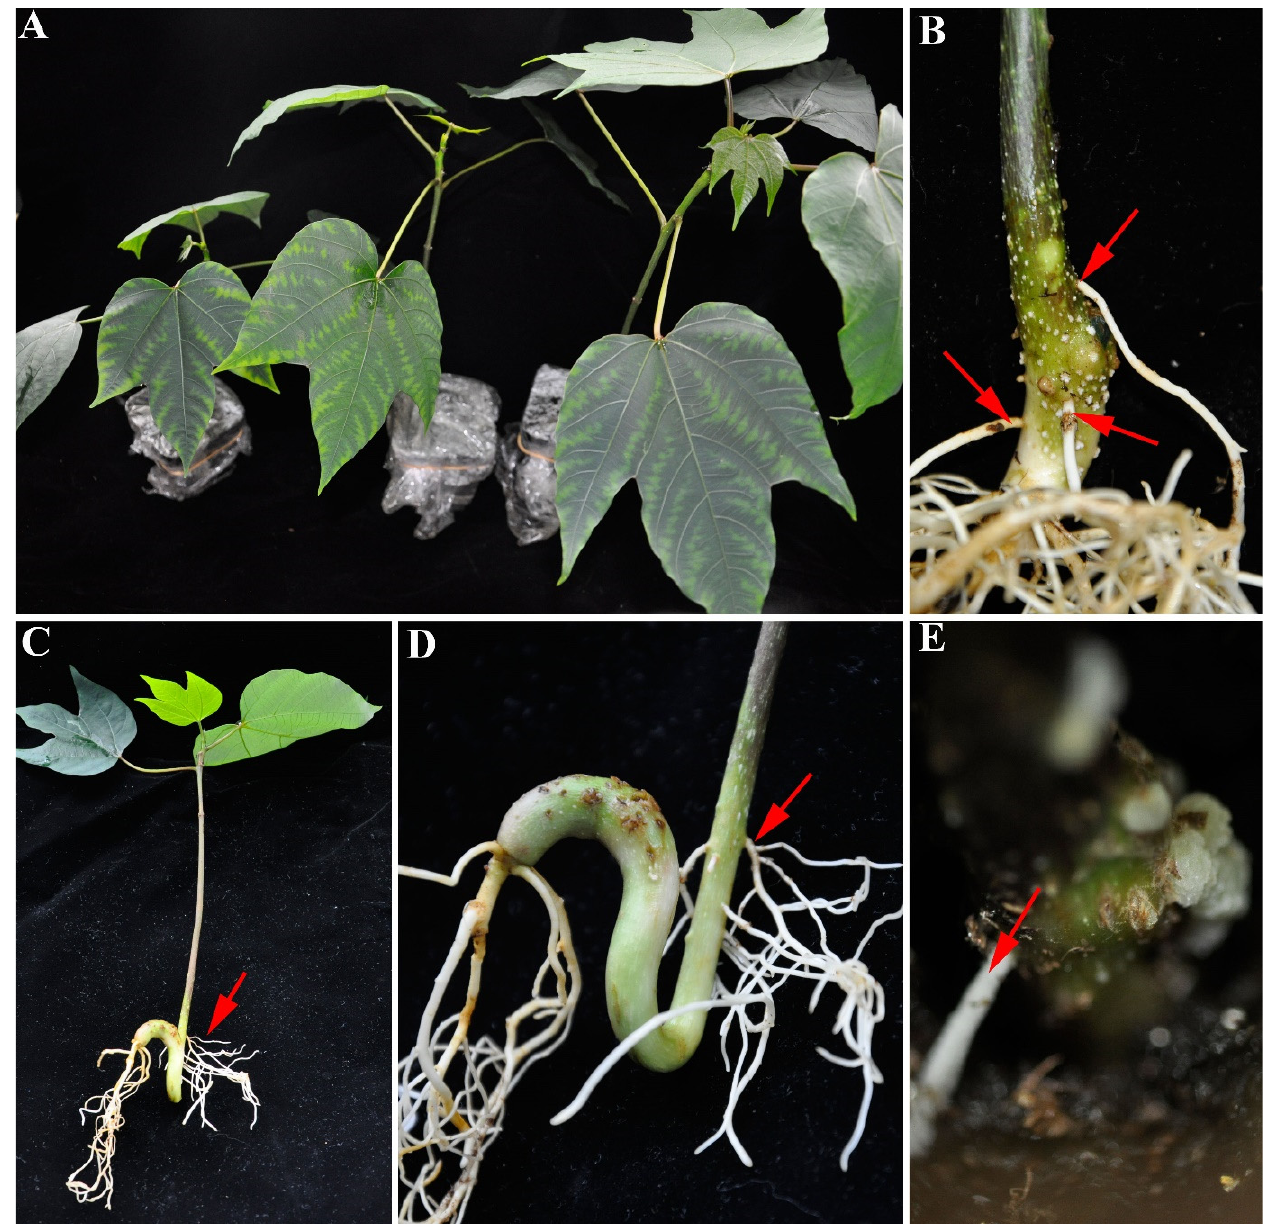
Figure 2. Induction of hairy roots in the stem of Vernicia montana by the modified method shown in Figure 1. ( A ) Seedlings after injection are shown. ( B ) Stems four weeks after injection. Hairy roots and many tiny calli are apparent. ( C ) The whole seedling, with hairy roots, four weeks after injection. ( D ) The stem of seedlings from “C” that had hairy roots but no calli. ( E ) Stems of seedling four weeks after injection, showing callus and hairy roots. The arrows indicate the induced hairy roots.